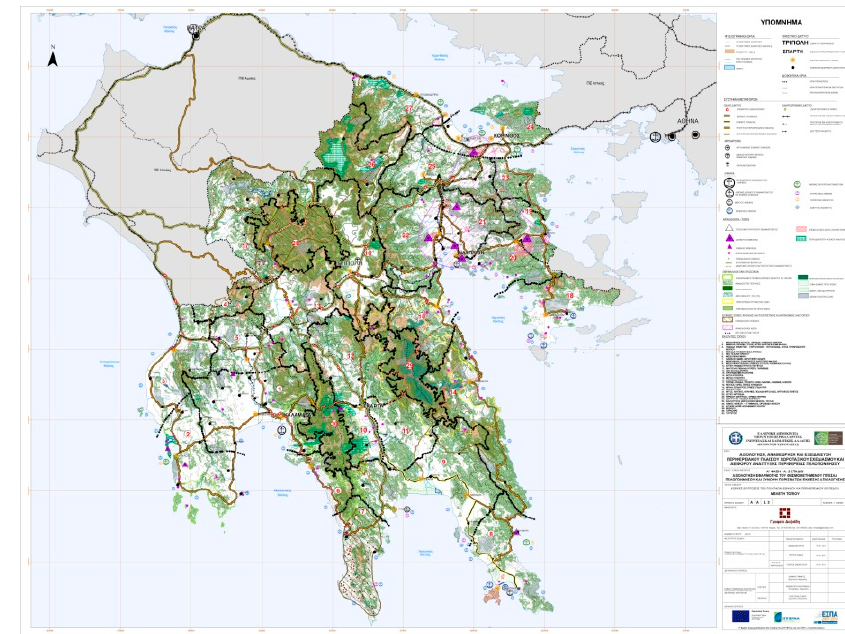
Figure 3. Landscape map of the Peloponnese Region, Source: Ministry of Environment and Energy, Revision and evaluation study of Peloponnese Regional Spatial Plan, 2016.